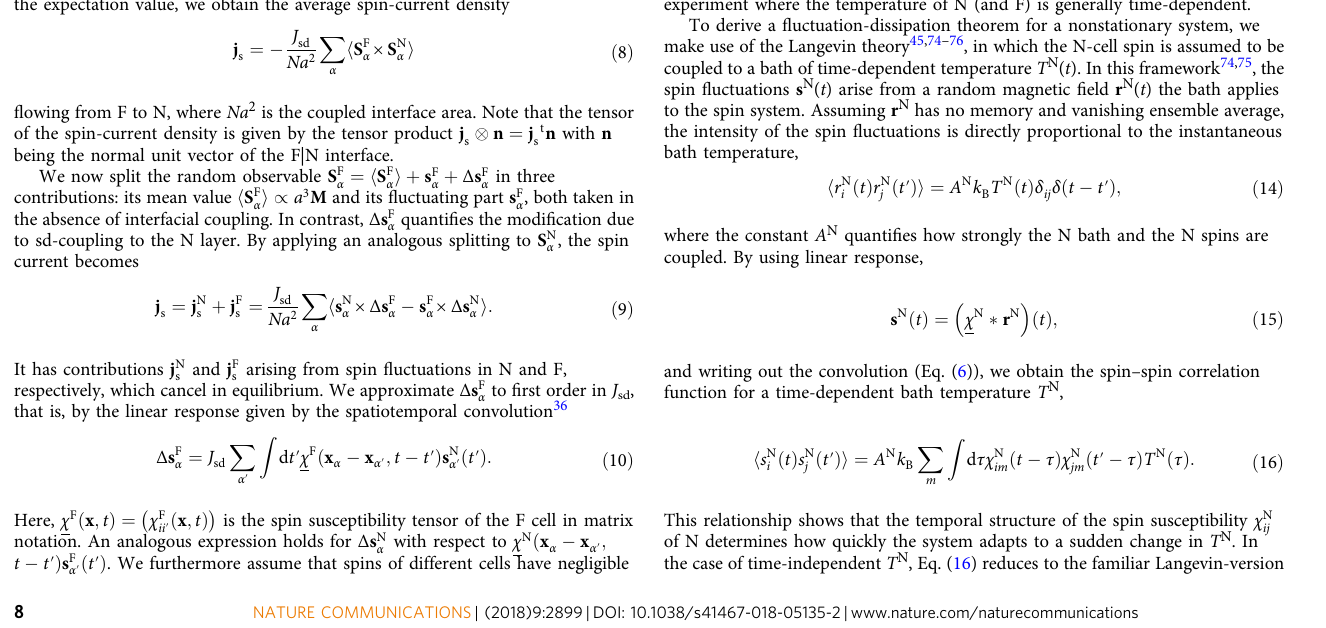
Derivation of the SSE current . As illustrated in Fig. 5a – d, interfacial F and N layers of thickness a are coupled by nearest-neighbor sd-type exchange interaction. We divide the interfacial plane in N cells of size a 3 and consider the total electron spin (cid:1) h S F α and (cid:1) h S N α contained in an F cell and N cell with index α , respectively. The expectation value of S F α is related to the F magnetization by h S F α i / a 3 M . According to ab initio simulations 38 , coupling between F and N spins is given P S F α (cid:2) S N α . Therefore, by the sd-exchange-type Hamiltonian 3,7,39,40 H sd ¼ J sd α